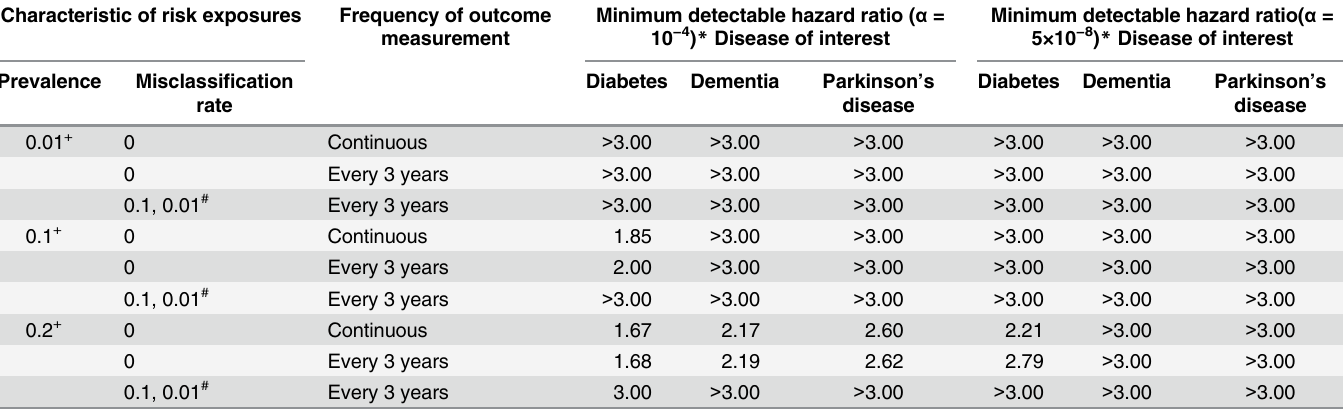
Table 3. Minimum detectable hazard ratio for gene-environment interaction.